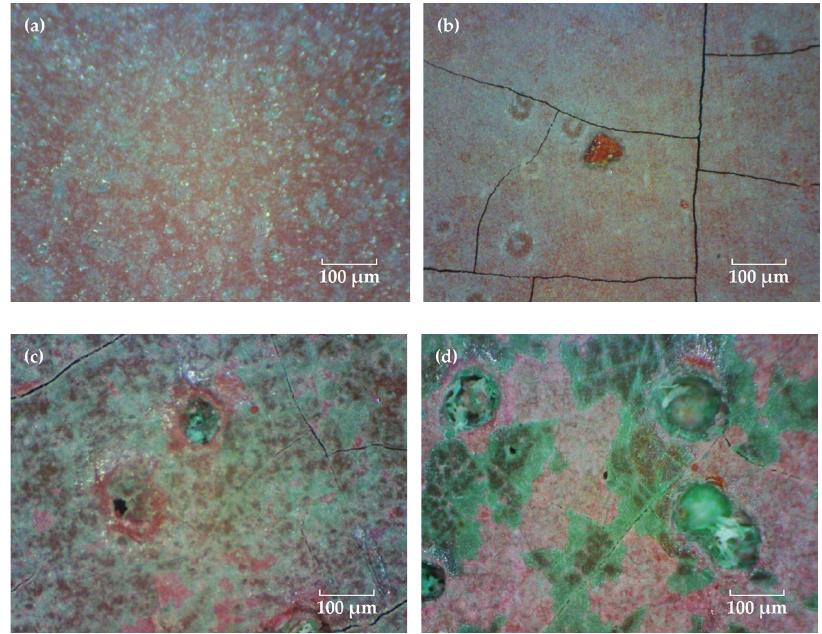
Figure 4. Surface micrographs of the FW-2 coating after immersion for different time. ( a ) 0 day, ( b ) 20 days, ( c ) 90 days and ( d ) 160 days.